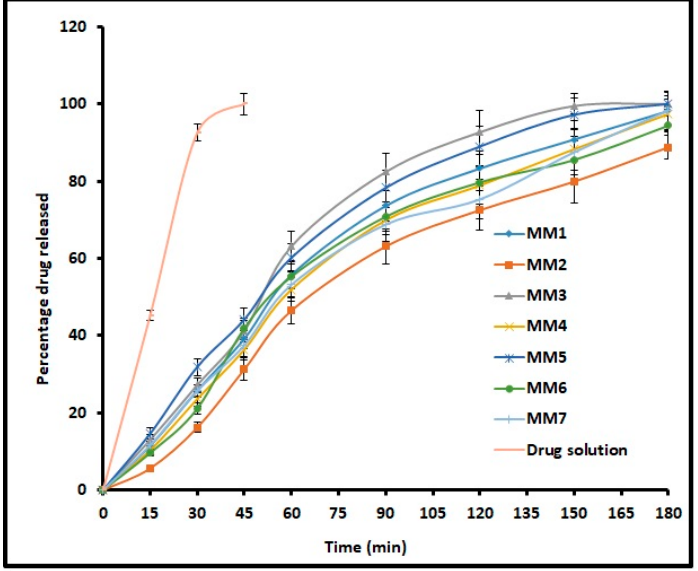
Table 3. Model fitting for selected nanoemulsion (MM3).